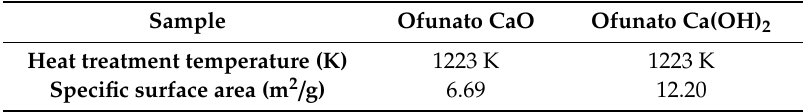
Table 4. Specific surface area of Ofunato CaO and Ofunato Ca(OH) 2 after decarbonization at 1223 K for 5 h in a mu ffl e furnace.